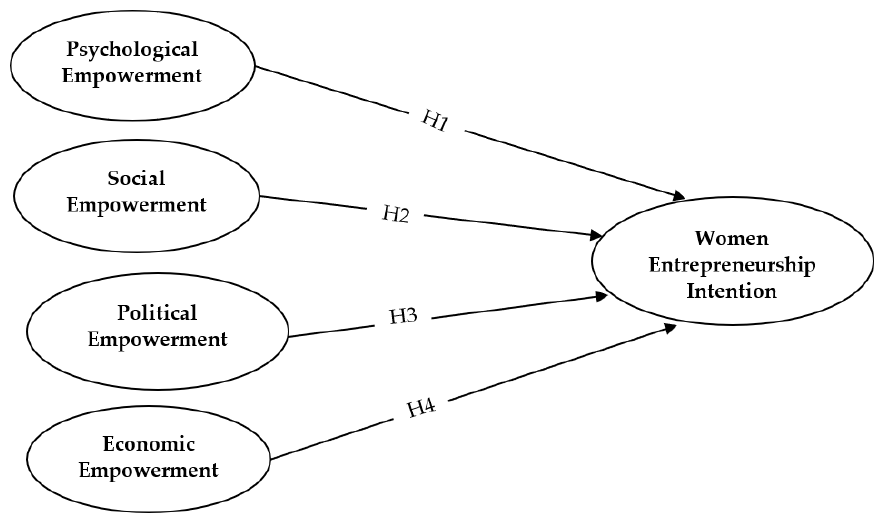
Figure 1. The research theoretical model.